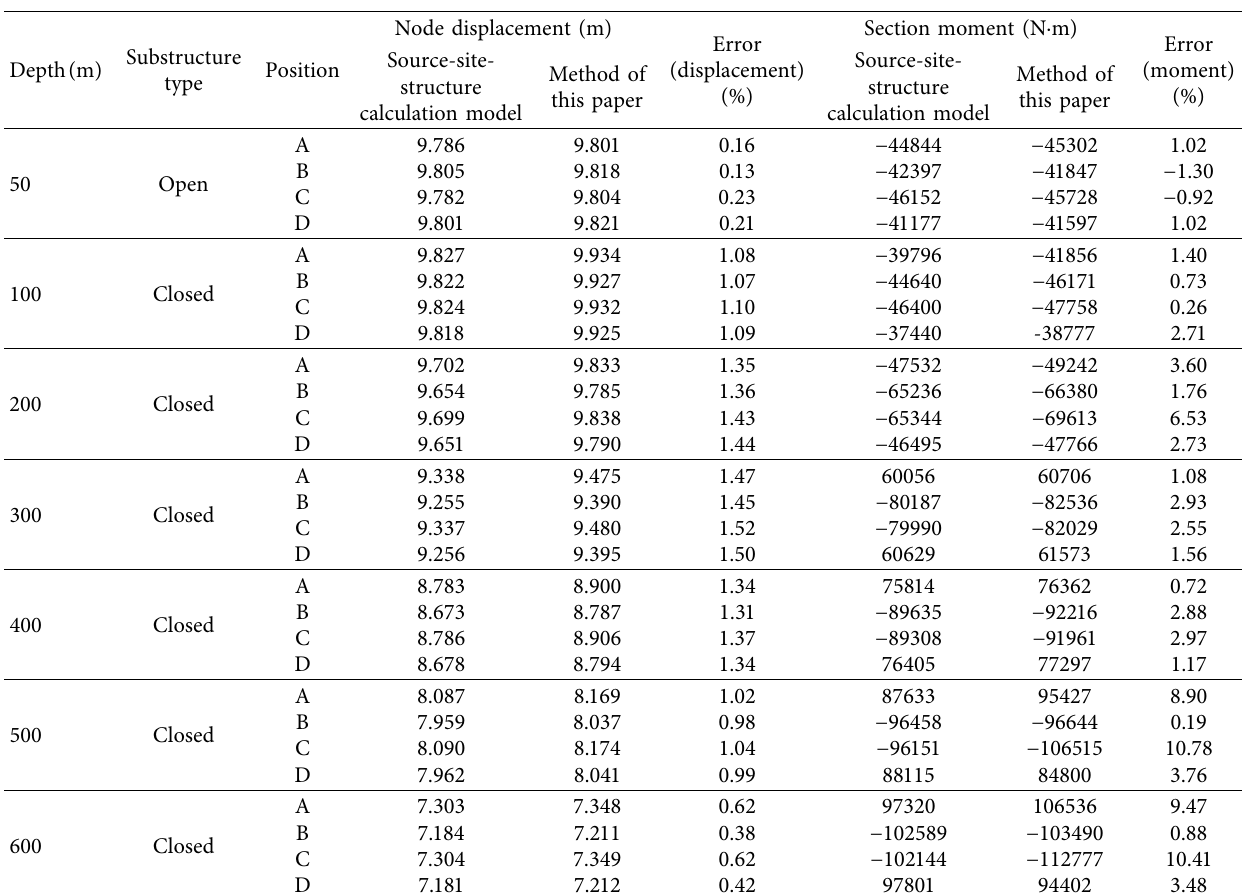
Table 3: Maximum node displacement and bending moments of 4 positions of structure at different depths (N · m). Substructure Depth(m)